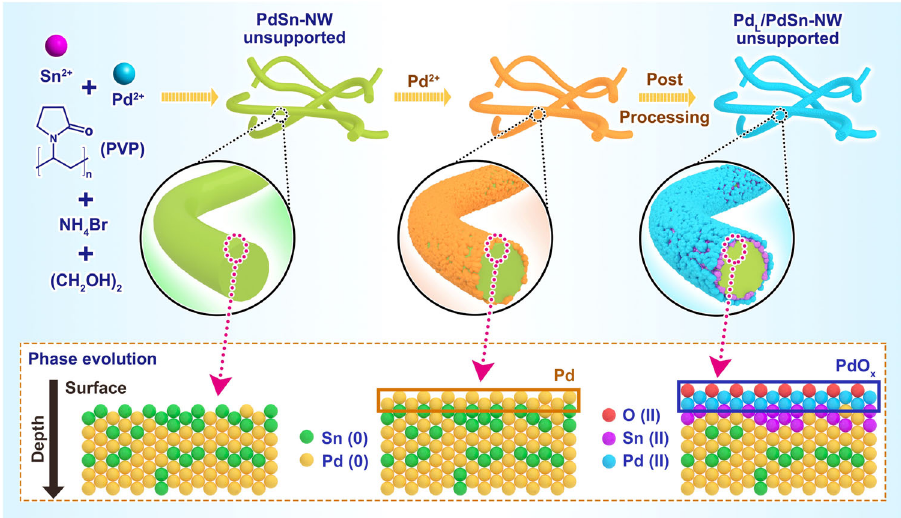
Fig.1|SchematicillustrationofthesynthesisoftheunsupportedPdSn-NWand Pd L /PdSn-NW. ThesupportedPdSn-NWandPd L /PdSn-NWcatalystsaresupported on TiO 2 . The two-step protocol involving an annealing process was used for the synthesis of Pd L /PdSn-NW. PdSn nanowire (NW) was prepared with a Pd: Sn molar